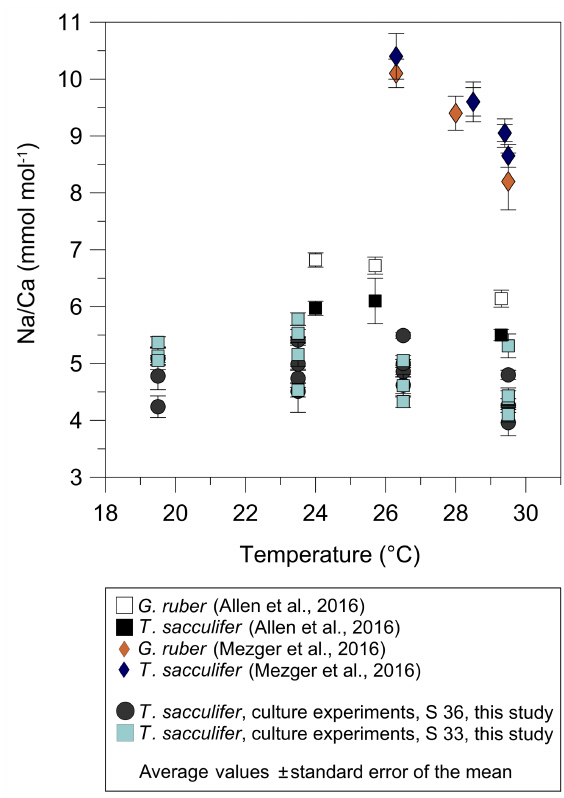
Figure 8. Comparison of foraminiferal Na / Ca values in response to temperature changes between this study’s T. sacculifer from culture experiments and published Na / Ca data of planktonic foraminifera from Allen et al. (2016) and Mezger et al. (2016). Averaged Na / Ca values of our study are shown in two different settings at either a constant salinity of 33 (grey dots) or 36 (light blue squares). Dur- ing culture experiments from Allen et al. (2016) the salinity slightly decreased from 35.6 to 35.2 with increasing temperatures from 24 to 29.3 ◦ C. Although in the field calibration study of Mezger et al. (2016) Na / Ca values apparently decrease with increasing tem- perature, corresponding salinities also decrease from 39.6 to 36.8. Vertical error bars are based on the standard error of the mean. Except for specimens from the Red Sea influenced by covarying factors ( G. ruber : R 2 = 0 . 84, p < 0 . 001; T. sacculifer : R 2 = 0 . 95, p < 0 . 001; Mezger et al., 2016), all Na / Ca data for T. sacculifer and G. ruber show no significant response to temperature changes (our study; Allen et al.,